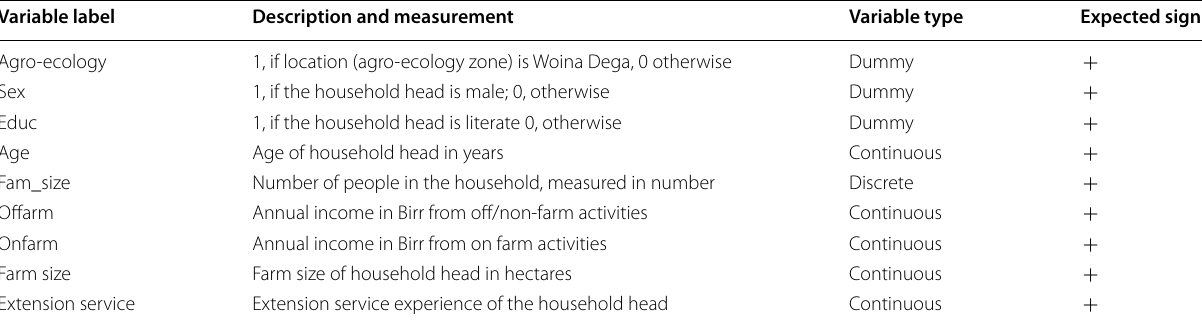
Table 1 Variables hypothesized to affect adaptation decisions by farmers in the Study area Variable label Description and measurement